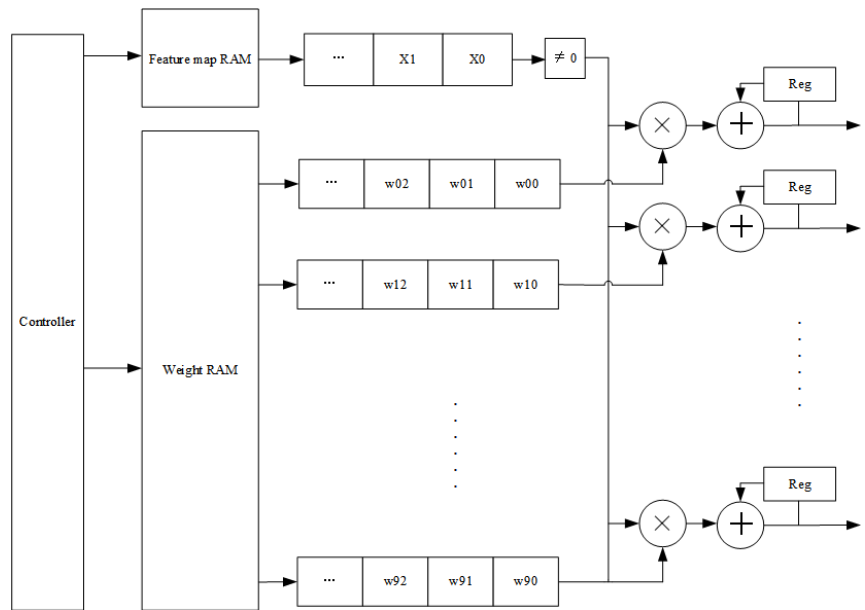
Figure 13. Hardware design architecture of the fully connected layer.